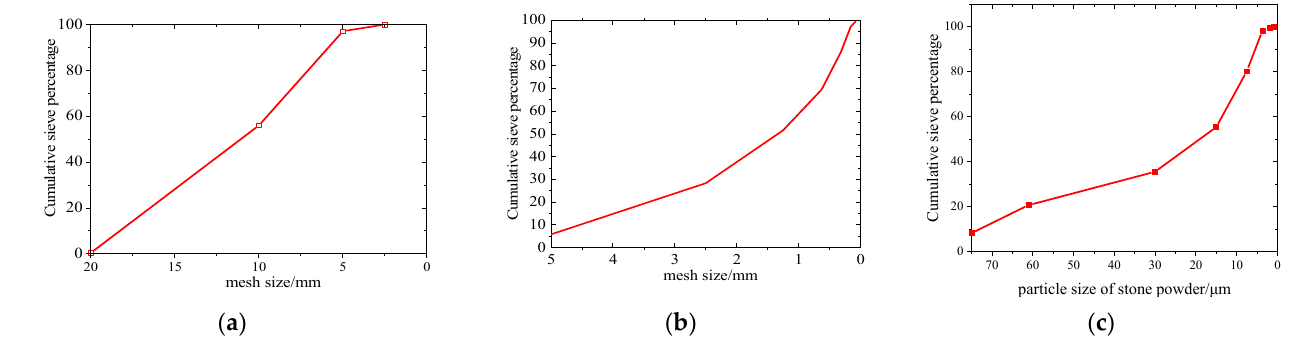
Figure 2. The particle size distribution curves for the aggregates: ( a ) coarse aggregate, ( b ) fine aggregate, and ( c ) stone powder. Table 2. Performances of water-reducing admixture.